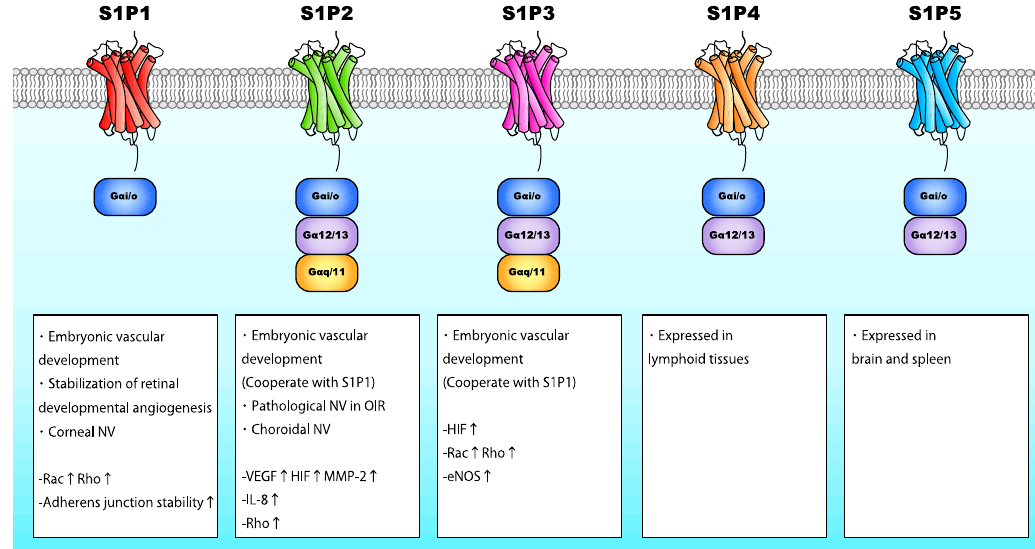
Figure 6. Biological effects of S1P receptors in neovascularization through the interaction with G proteins. S1P exerts various cellular functions by activating different S1P receptors. proteins. S1P exerts various cellular functions by activating di ff erent S1P